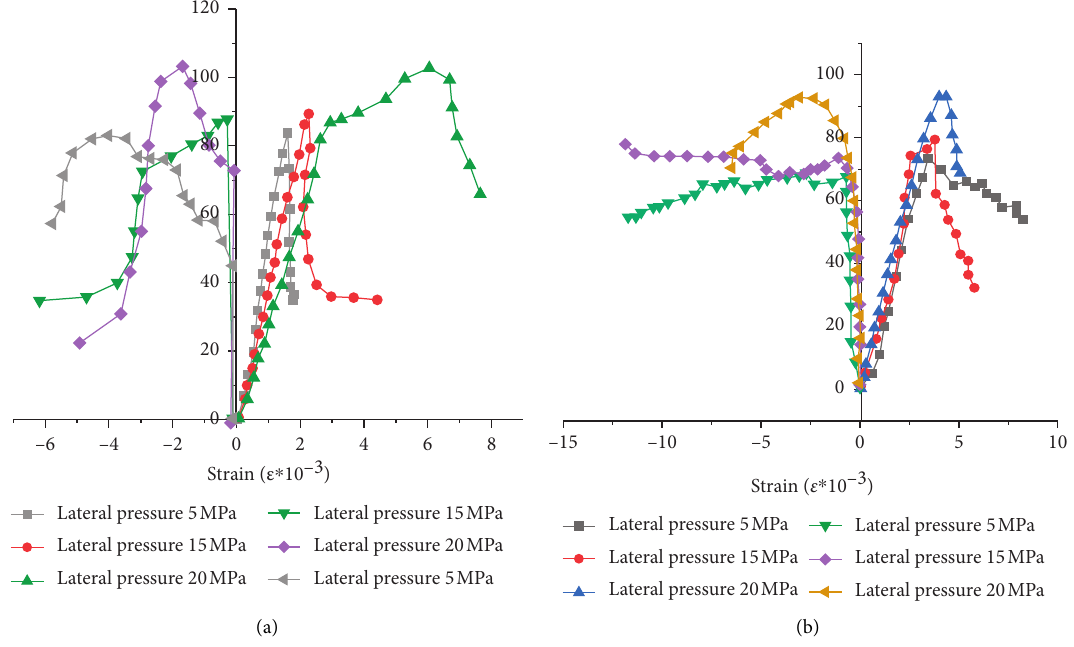
Figure 3: Typical stress-strain curves for triaxial compression of carbonaceous micaceous rocks: (a) joint dip 0 ° ; (b) joint dip 90 ° .